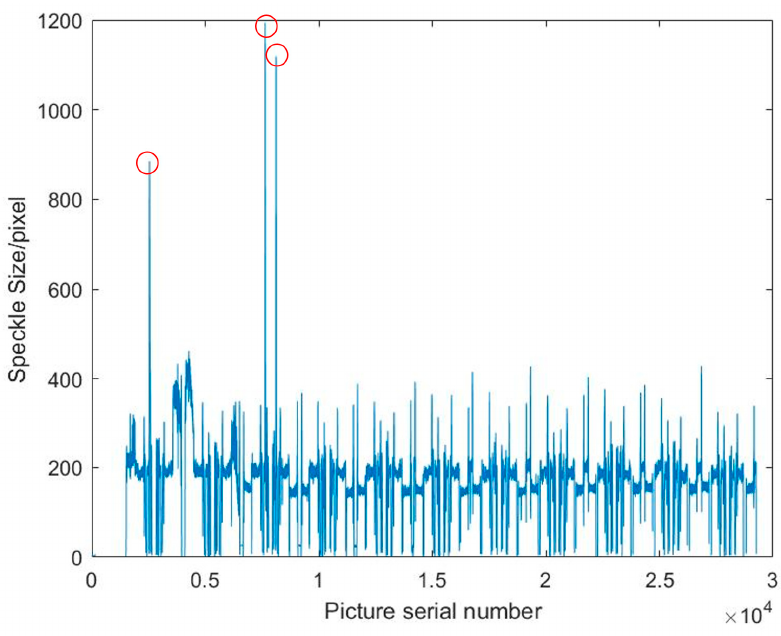
Figure 19. Curve of speckle size in measurement of the deposit surface.